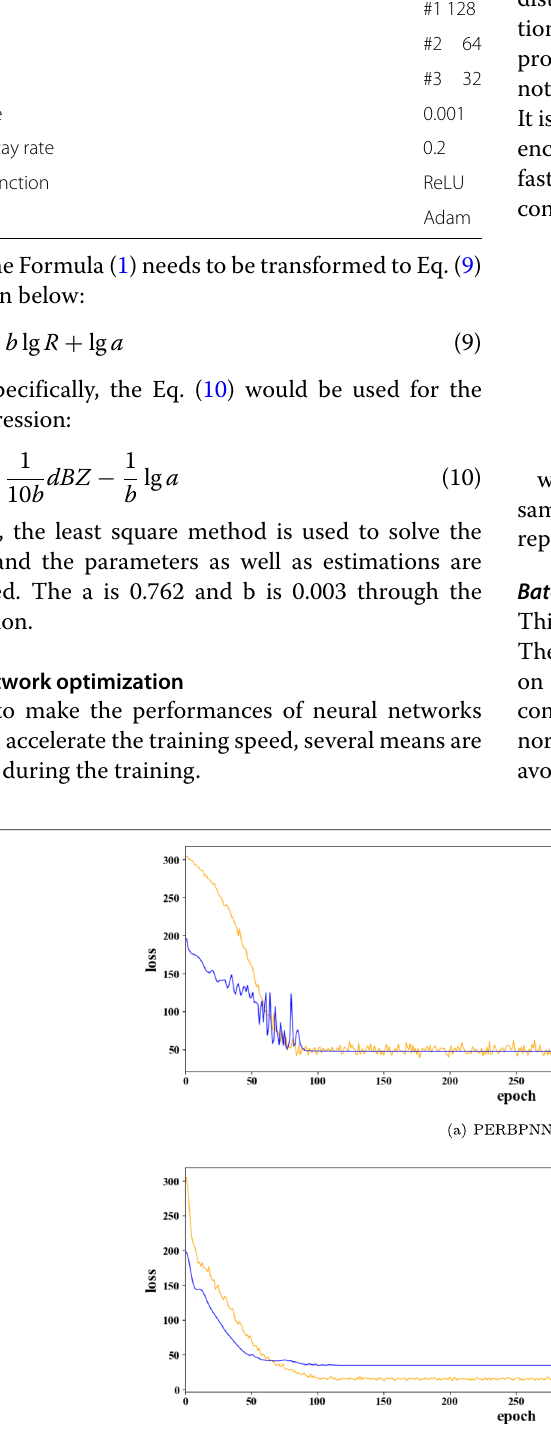
#1 128 #2 64 #3 32